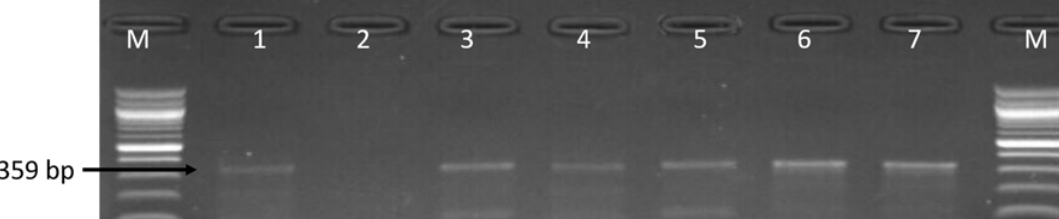
Figure 4. Gel electrophoresis image of PCR detected cstA (359 bp) gene of C. fetus . Lane M: molecular marker (100 bp), lane 1: positive control ( C. fetus ATCC 27374), lane 2: negative control, lane 3–7: some positive C. fetus isolates (359 bp).